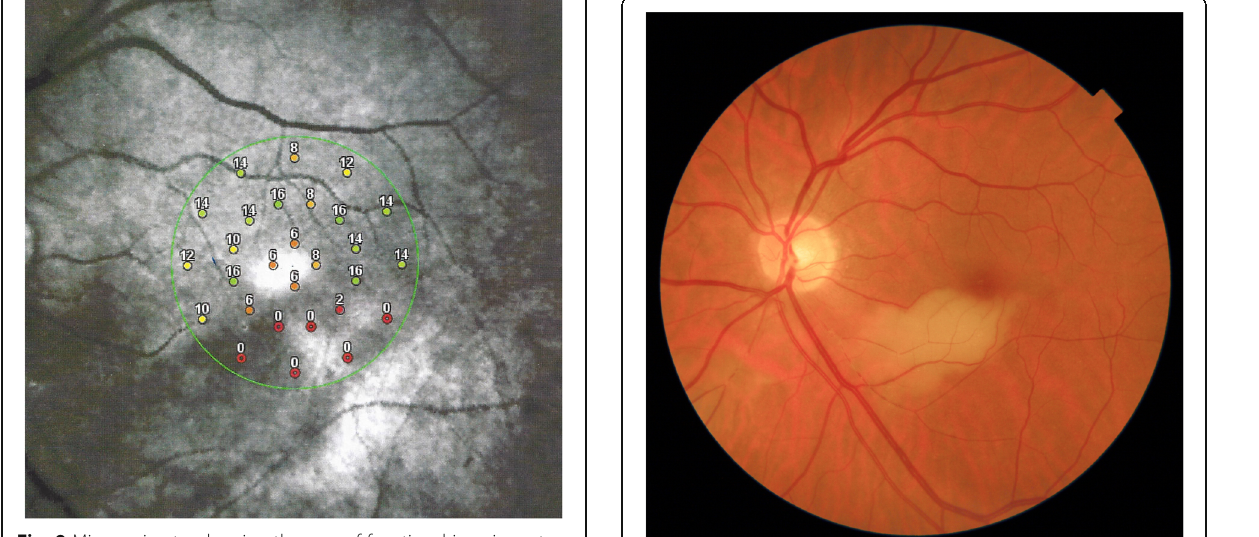
Fig. 9 Microperimetry showing the area of functional impairment caused by the retinal infarction. (Case 1)